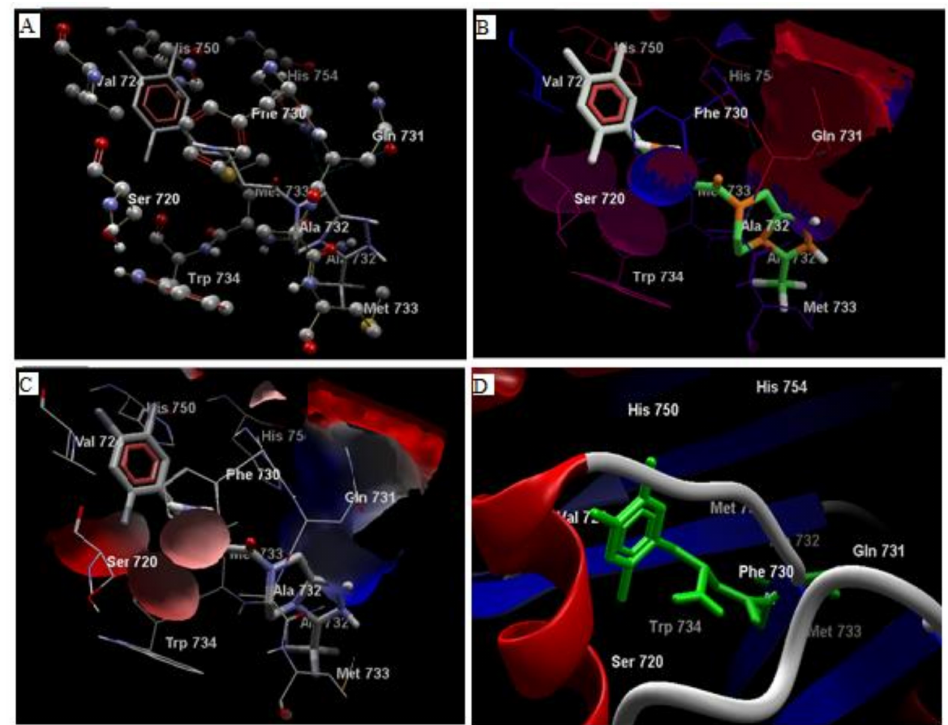
Figure 4. The hydrogen bonds ( A ), hydrophobic binding ( B ), electrostatic binding ( C ), and secondary protein interaction ( D ) of sitagliptin and dipeptidyl peptidase-IV